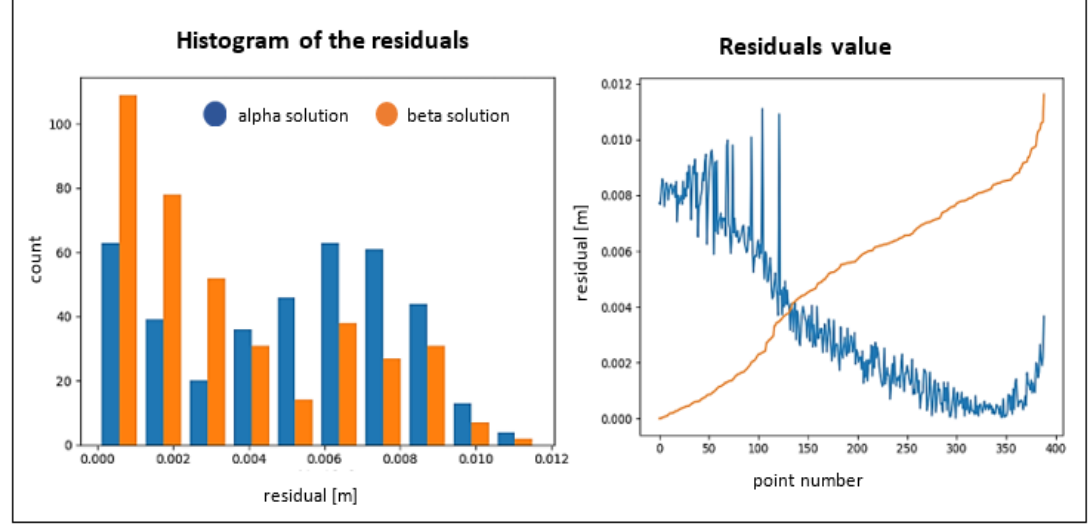
Figure 12. Precast concrete wall.